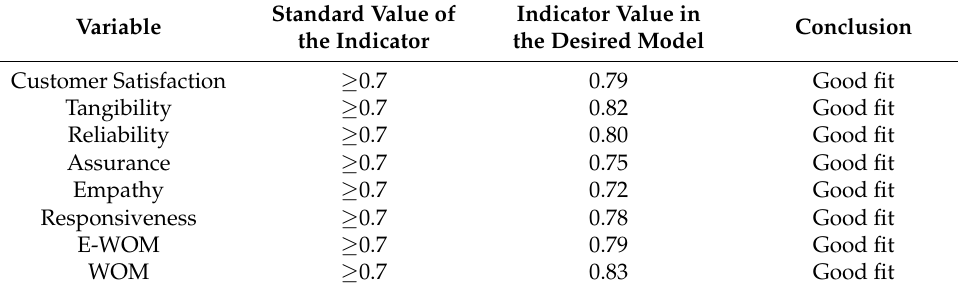
Table 3. Cronbach’s alpha.